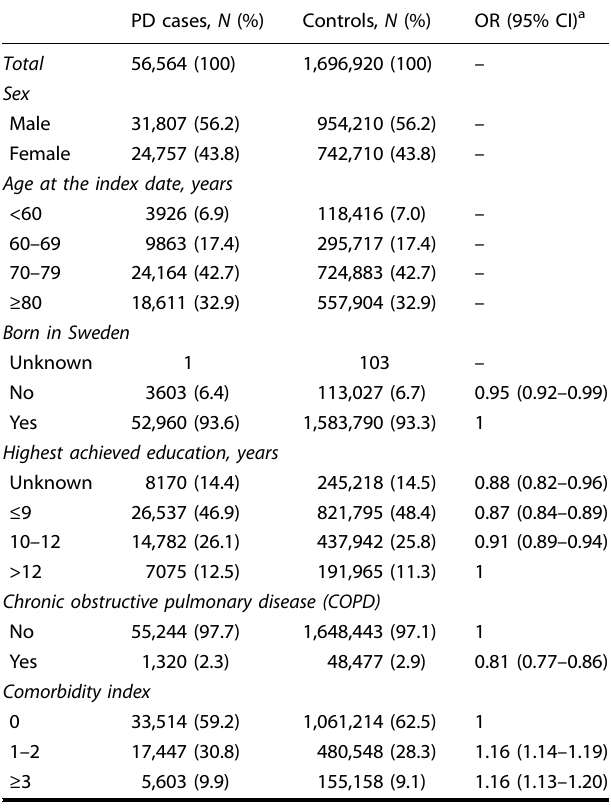
Table 1. Characteristics of Parkinson ’ s disease (PD) cases and controls from Swedish total population 1987 – 2010, N =